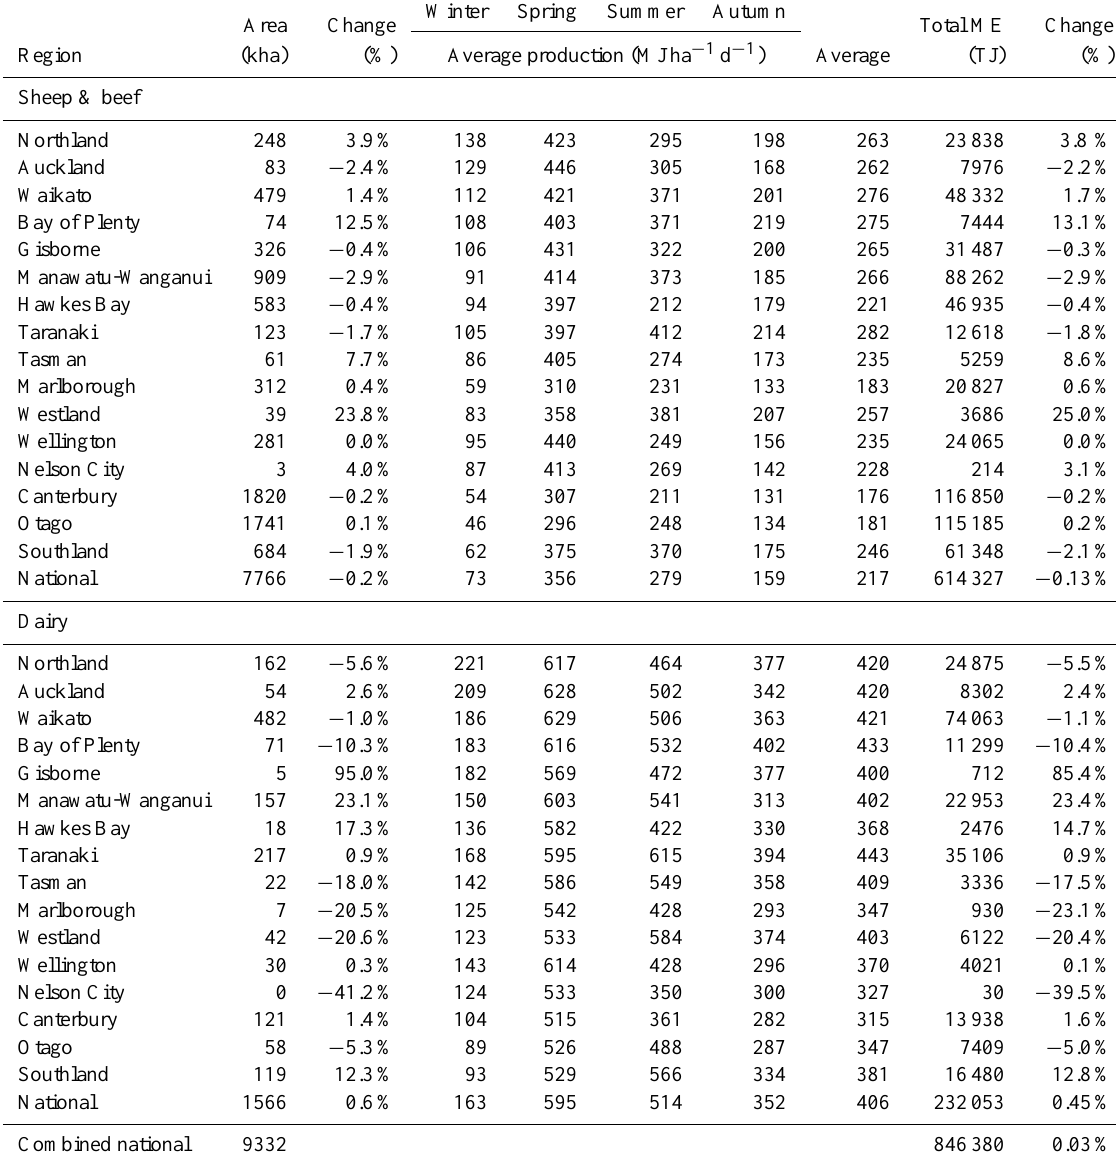
Table B9. Land-use change, 2020 CO 2 = NZD0.